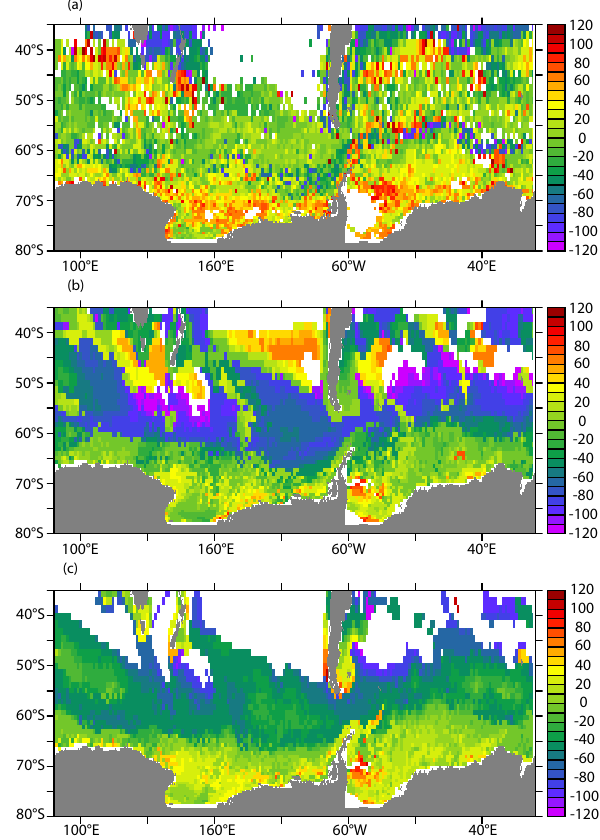
Figure 7. Seasonal phasing of the peak chlorophyll concentrations for (a) SEAWIFS, (b) CNTRL, and (c) WSTIR; units are days for a climatological year. Regions where the quantity is not well or de- fined or where the quantity and/or bloom are not well-defined are shown in